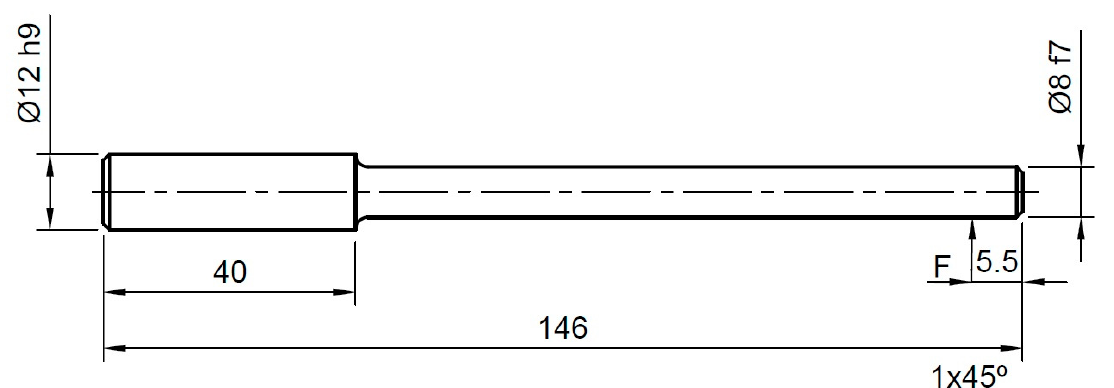
Figure 9. Dimensions of the test specimens used in the fatigue test.